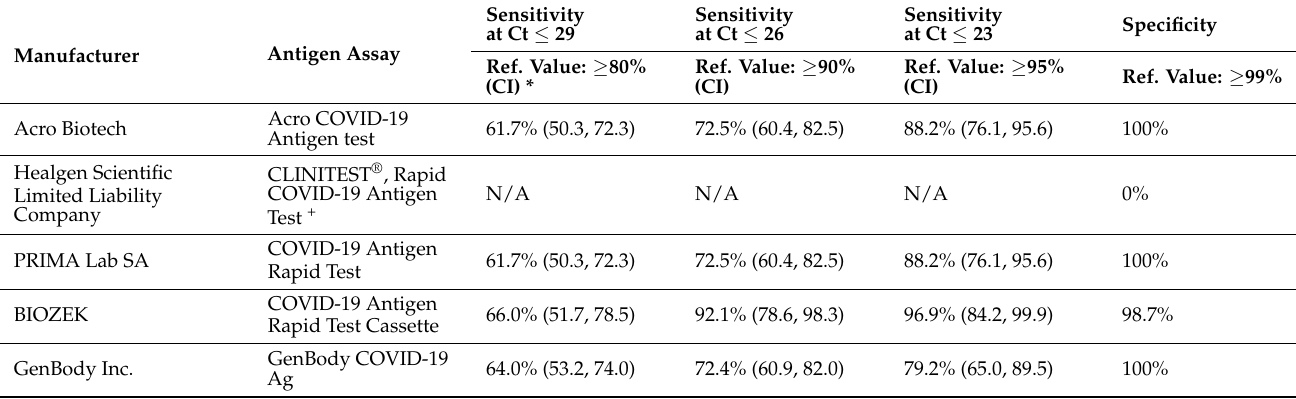
Table 2. Sensitivity and specificity rates of antigen tests failing the validation, stratified according to the viral load. Num- bers in brackets indicate the 95% confidence intervals.